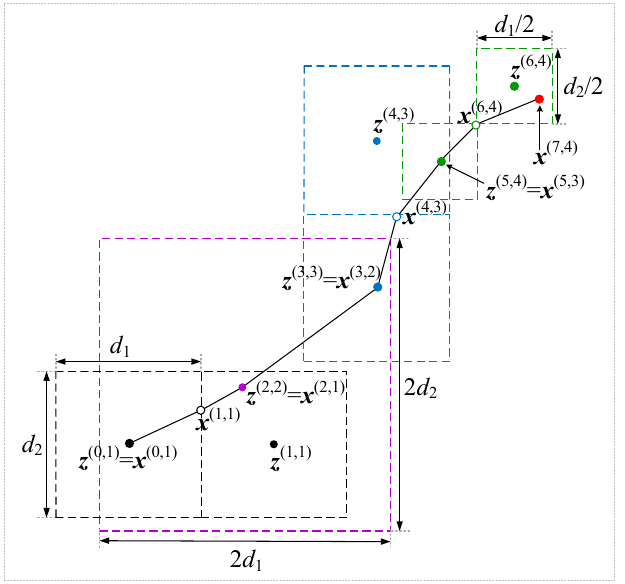
Figure 1. Multi-fidelity local surrogate model optimization (conceptual illustration for design parameter dimension n = 2). A local surrogate model s ( 0,1 ) (3) is established using R c .1 in the initial region of size [ d 1 d 2 ] (corresponding to d ( 0,1 ) = [ d 1 /2 d 2 /2 ] T ). It is optimized to yield a new design x ( 1,1 ) ,